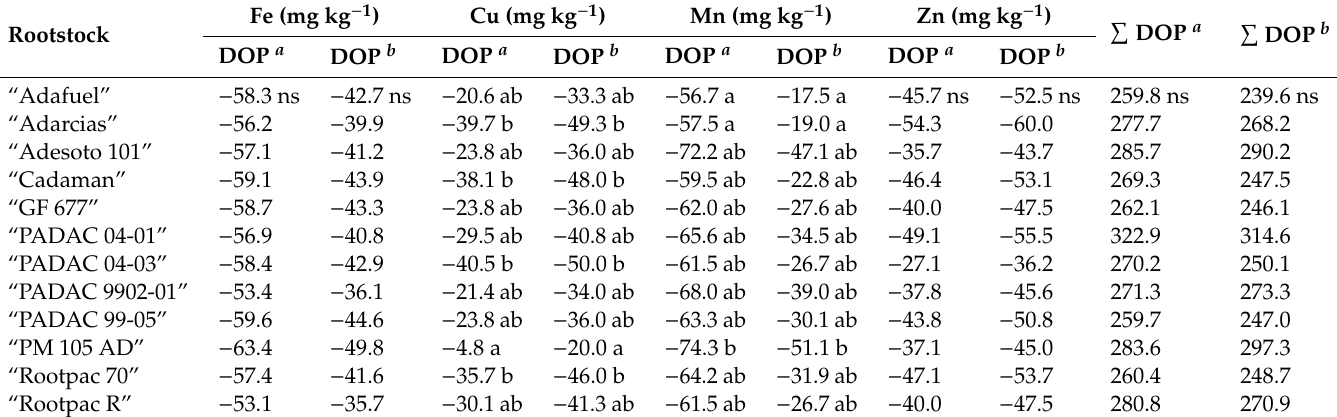
Table 12. Rootstock e ff ect on DOP index for each microelements of “Big Top” cultivar on twelve